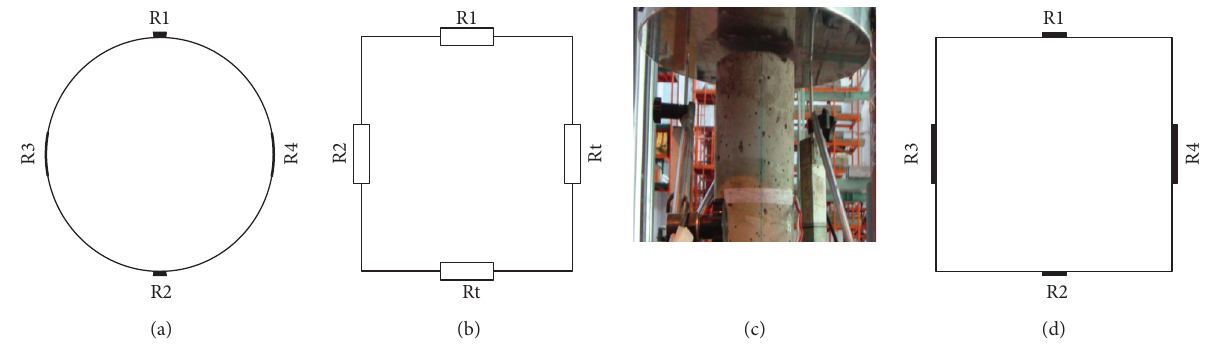
Figure 3: Measuring arrangement and connection mode of vertical strain gauge: (a) cylinder specimen profile; (b) connection of vertical strain gauges; (c) position of displacement meter; (d) prism specimen profile. Note: R1 and R2 are vertical strain gauges, R3 and R4 are transverse strain gauges, and Rt is temperature compensation strain gauge.